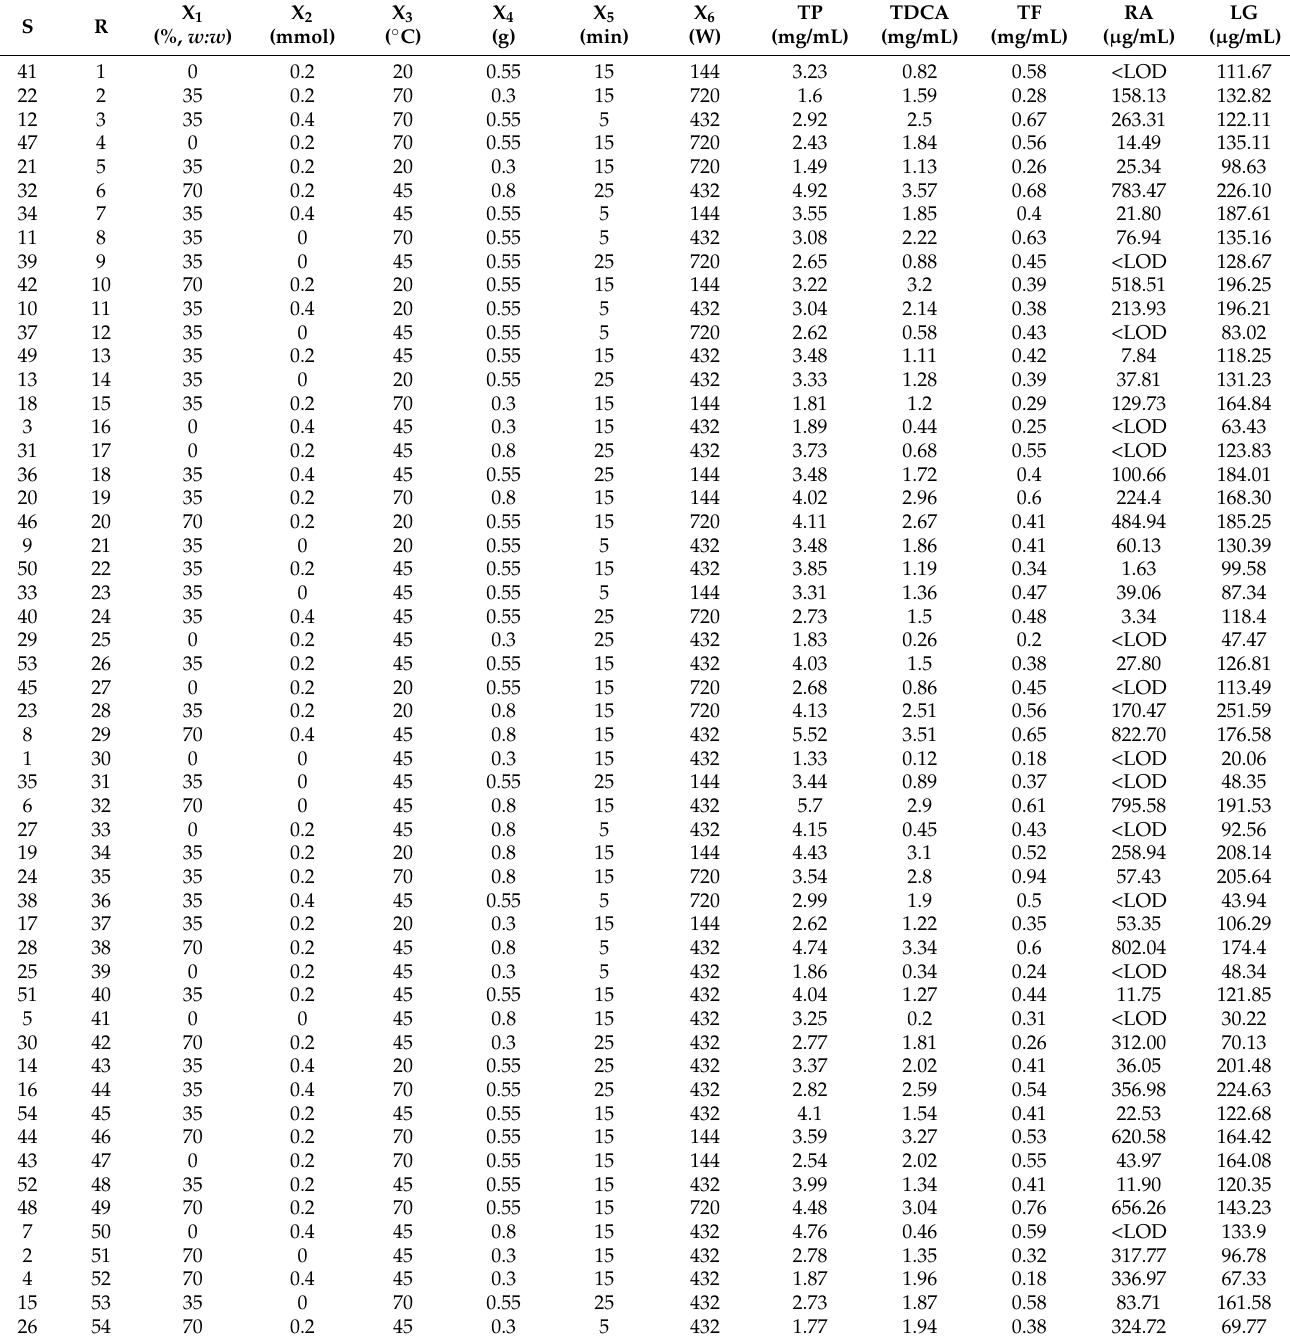
Table 2. The Box Behnken design with corresponding